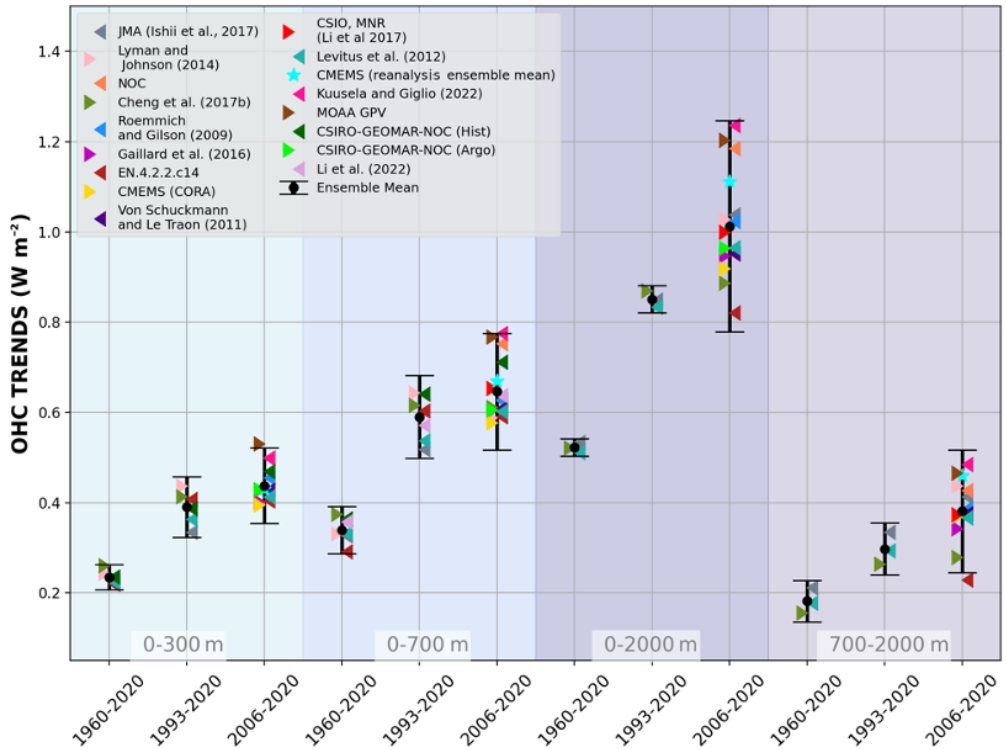
Figure 3. Trends of global ocean heat content (OHC) as derived from different products (colors) and using LOWESS (see text for more details). References are given in the figure legend, except for CMEMS (CORA, Copernicus Marine Ocean Monitoring Indicator, 2023), EN.4.2.2.c14 (Good et al., 2013) with Cheng et al. (2014), XBT (Gouretski and Cheng, 2020), and Mechanical Bathythermograph (MBT) bias corrections, as well as for the method by Palmer et al. (2007). CSIRO-GEOMAR-NOC (Argo) (Domingues et al., 2008; Wijffels et al., 2016; Roemmich et al., 2015), CSIRO-GEOMAR-NOC (hist) (Church et al., 2011; Domingues et al., 2008), NOC (National Oceanographic Centre) (Desbruyères et al., 2017), and the Argo dataset MOAA GPV (Hosoda et al., 2008) are also included. Results from the Copernicus Marine Service Global Reanalysis Ensemble Product have been added as well (Copernicus Marine Ocean Monitoring Indicator: global ocean heat content) for comparison but are not considered for the ensemble mean in Fig. 1. The ensemble mean and standard deviation (95% confidence interval) are indicated in black. The shaded areas show trends from different depth layer integrations, i.e., 0–300m (light turquoise), 0–700m (light blue), 0–2000m (purple), and 700–2000m (light purple). For each integration depth layer, trends are evaluated over the three study periods, i.e., historical (1960–2020), altimeter era (1993–2020), and golden Argo era (2006–2020). See text for more details on the international assessment criteria. Note that values are given for the ocean surface area (see text for more details). References as indicated in the legend include the following: Cheng et al. (2017a); Gaillard et al. (2016); Good et al. (2013); Ishii et al. (2017); Kuusela and Giglio (2022); Levitus et al. (2012); Li et al. (2017, 2022); Lyman and Johnson (2014); Roemmich and Gilson (2009); and von Schuckmann and Le Traon